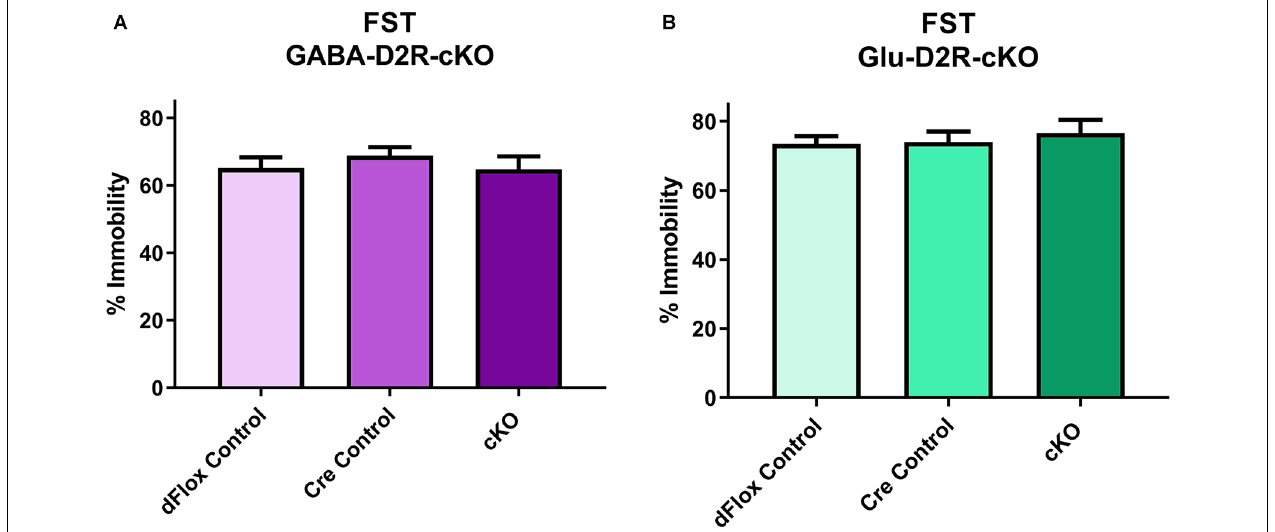
FIGURE 8 | No changes in depression-related behavior in GABA-D2R-cKO and Glu-D2R-cKO mice. No changes in immobility were detected in either the GABA-D2R-cKO (A) or the Glu-D2R-cKO (B) lines when tested in the FST. Data depict the percent of time spent immobile in the final 4 min of the test. N =